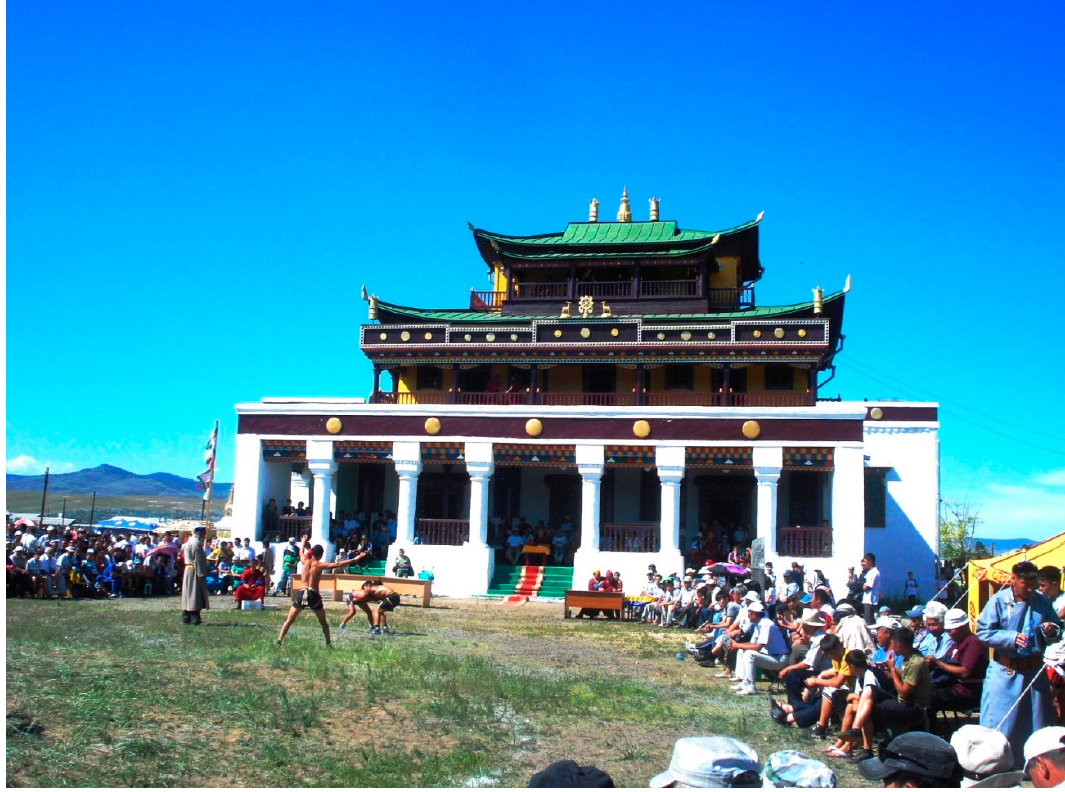
Figure 6. Youth wrestling tournament during “Eryn Gurban Naadan” organized in the Tamchinskiy Datsan in Southern Buryatia in summer 2011. Photo: Stefan Krist.